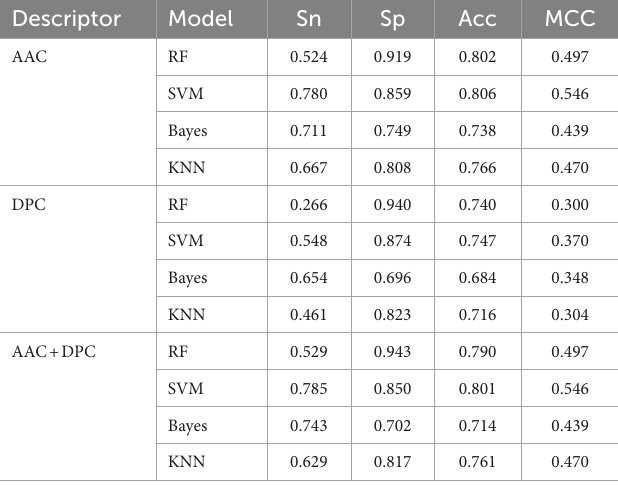
TABLE 1 Prediction results of AAC and DPC descriptors for psychrophilic and non-psychrophilic proteins. Descriptor